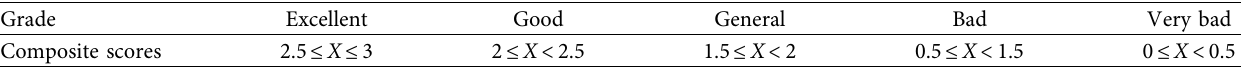
Table 14: Grade table of comprehensive evaluation score.